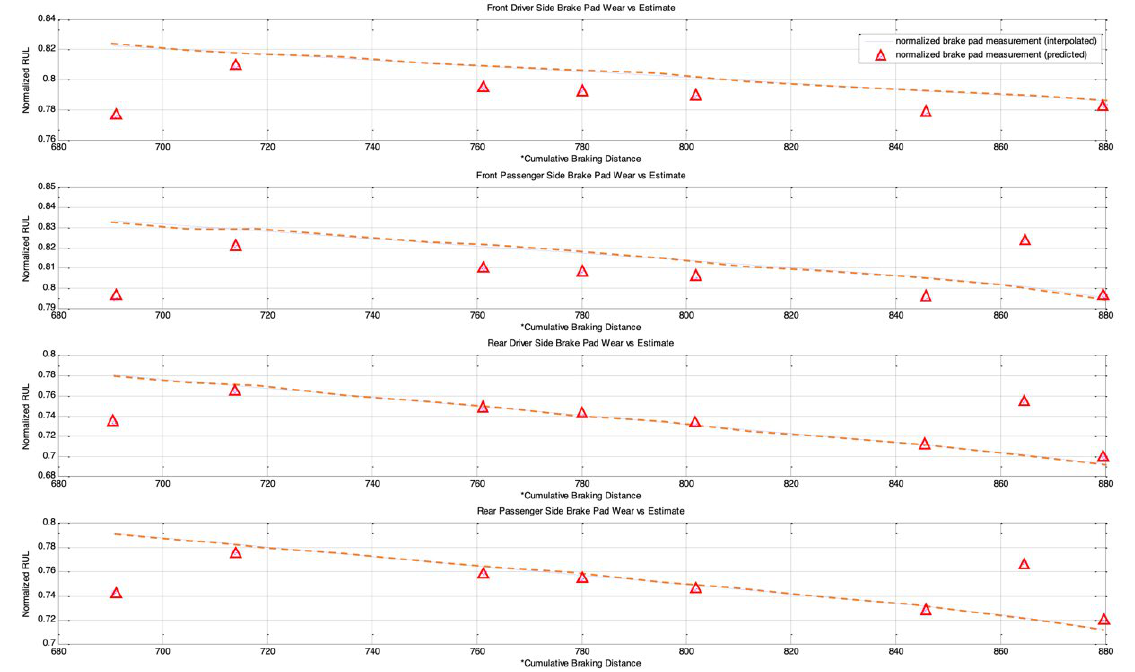
Figure 23. Driver #5, inferred normalized brake wear (dashed-line) vs. predicted brake wear (triangle). Top–bottom shows front driver side, front passenger side, rear driver side, and rear passenger side.